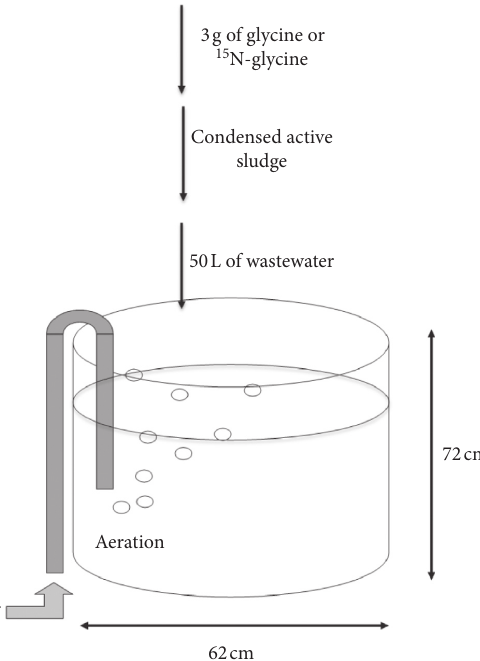
Figure 1: The cylindrical tank used to prepare the labeled sludge with 15 N-glycine. 50 L of wastewater from a bean curd factory was mixed with 1L of active sludge and 3g of 15 N-glycine (98 atom% 15 N) and aerated at 25 L · min − 1 from the bottom of the cylindrical tank, 72cm h × 62cm ϕ , at 25 ° C for 5 days. During the aeration, samples were collected and allowed to stand for 1h for floc sedi- mentation, and the supernatant was recovered to estimate various parameters described in Section 2.4. Experiments without the addi- tion of glycine were done several times. The mixing with cold glycine and with 15 N-glycine was performed 3 times and 1 time,